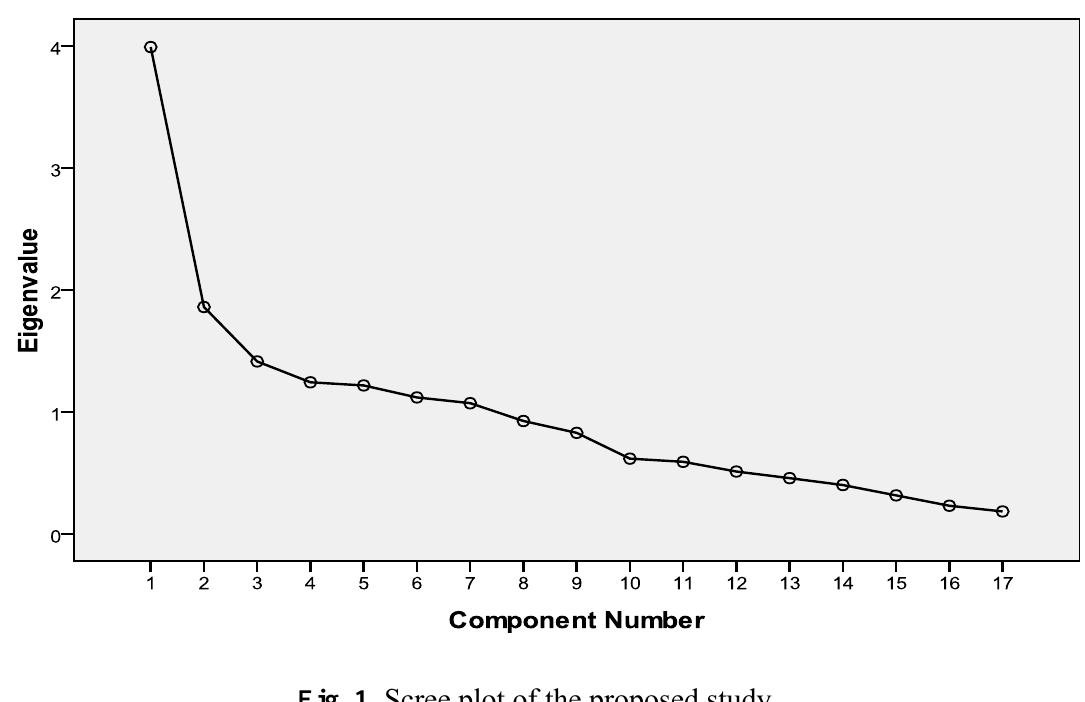
Fig. 1. Scree plot of the proposed study